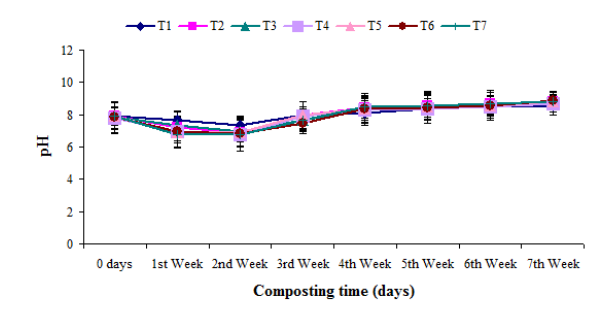
Fig. 2. Changes of pH during composting of press mud. T Control (Without microorganism); T + CM; T : PM + Salmonella sp. + CM; T 3 CM; T : PM + Klebsiella sp. + CM; T 5 + CM; T : PM+ Consortium+ CM. 7